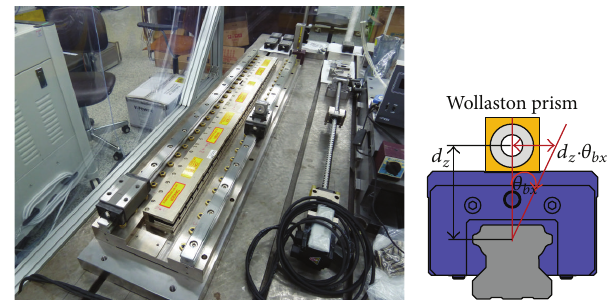
Figure 11: The setup used to measure the straightness error.